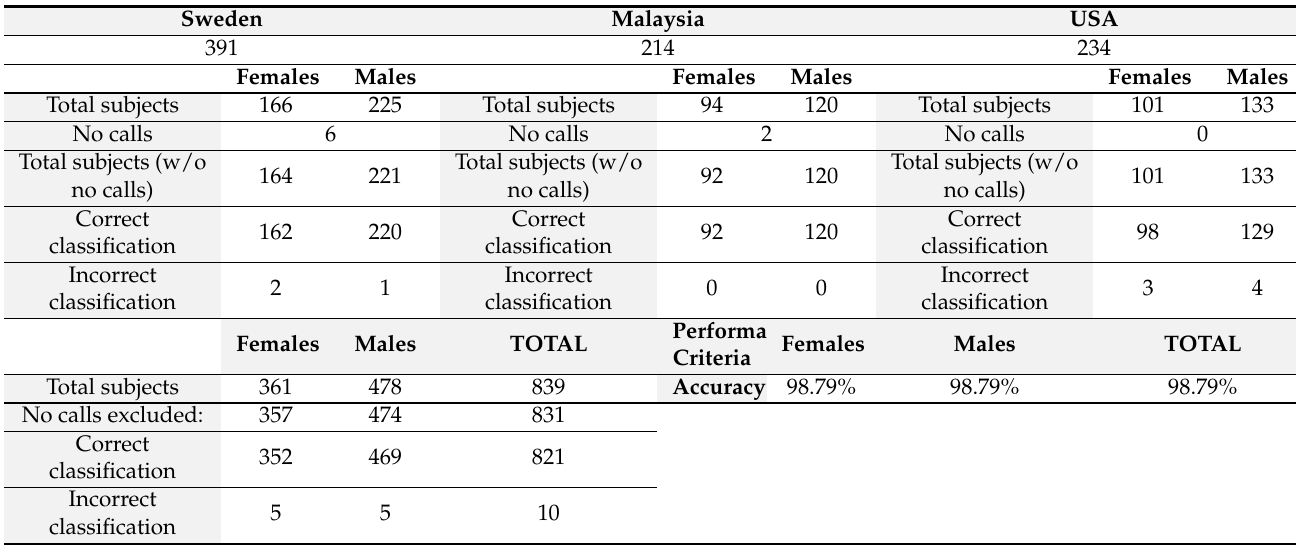
Table 3. Test performance Vanadis ® NIPT—sex